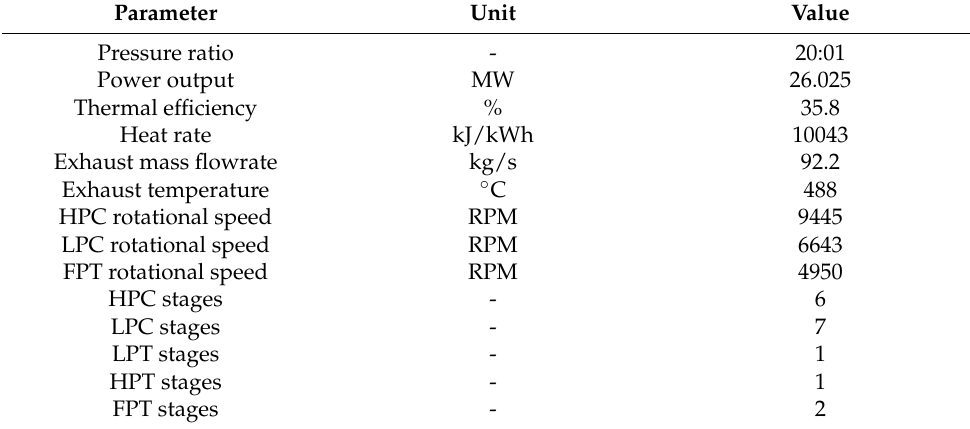
Table 2. Parameters used as